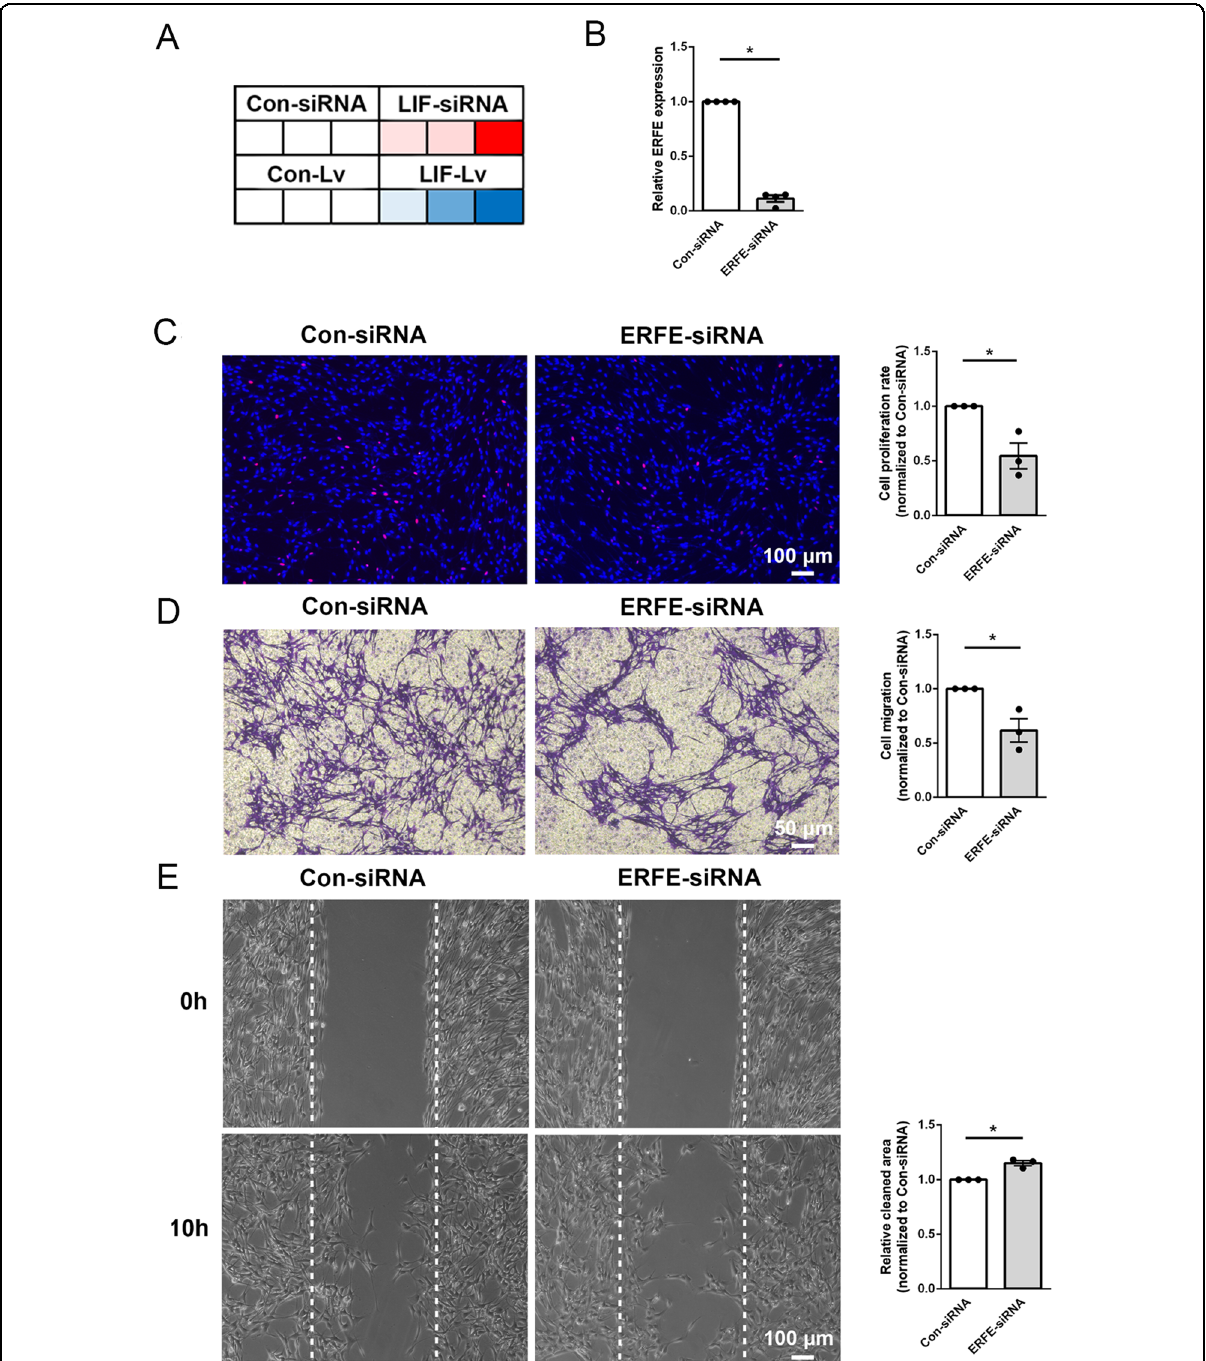
Fig. 8 ERFE-siRNA suppresses Schwann cell proliferation and migration. A Heatmap of the relative expression levels of LIF mRNA in Schwann cells transfected with LIF-siRNA or LIF-overexpressing lentivirus (LIF-Lv). Red color indicates upregulation and blue color indicates downregulation. B Transfection of Schwann cells with ERFE-siRNA reduces the relative abundance of ERFE mRNA. C ERFE-siRNA transfection decreases Schwann cell proliferation. Red color indicates EdU-positive cells and blue color indicates nucleus. Scale bar indicates 100 μ m. D ERFE-siRNA transfection decreases Schwann cell migration. Violet color indicates migrated cells. Scale bar indicates 50 μ m. E ERFE-siRNA increases cleaned areas between scratches. Scale bar indicates 100 μ m. Data were presented as means ± SEM. * p value <0.05 versus control-siRNA